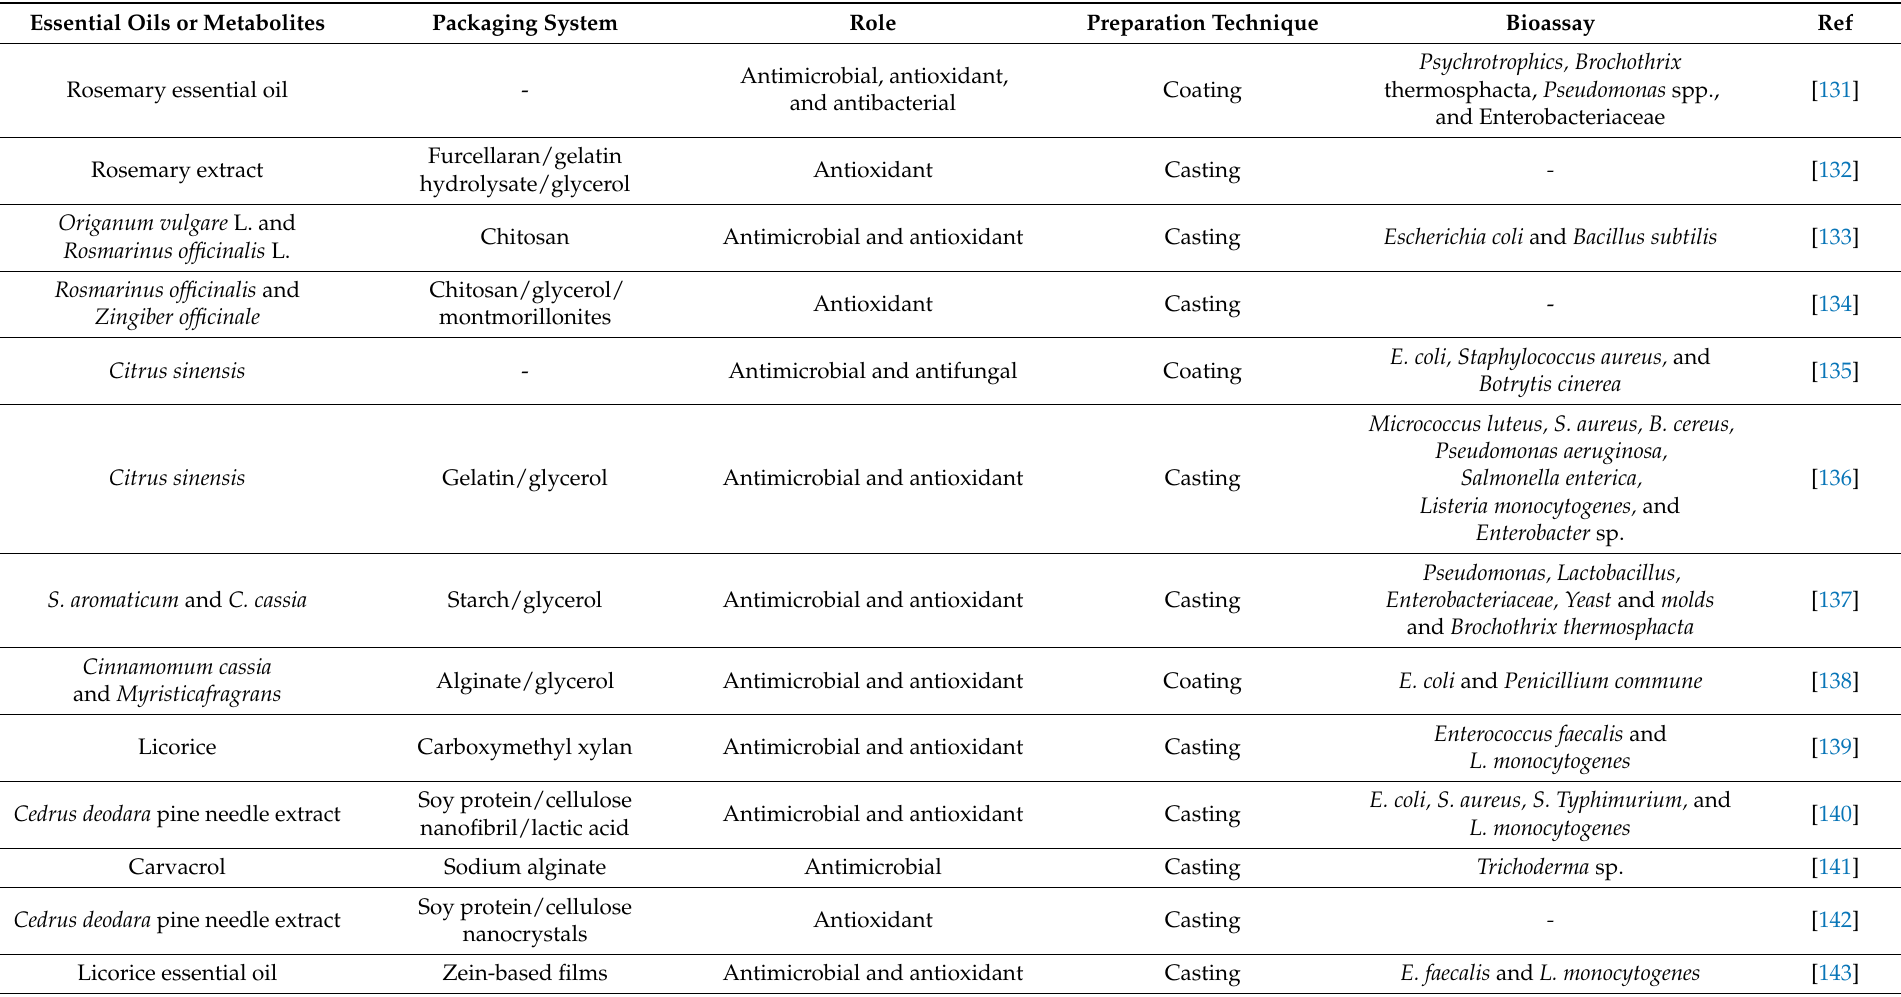
Table 1. Natural products as antioxidants and antimicrobials in active bio